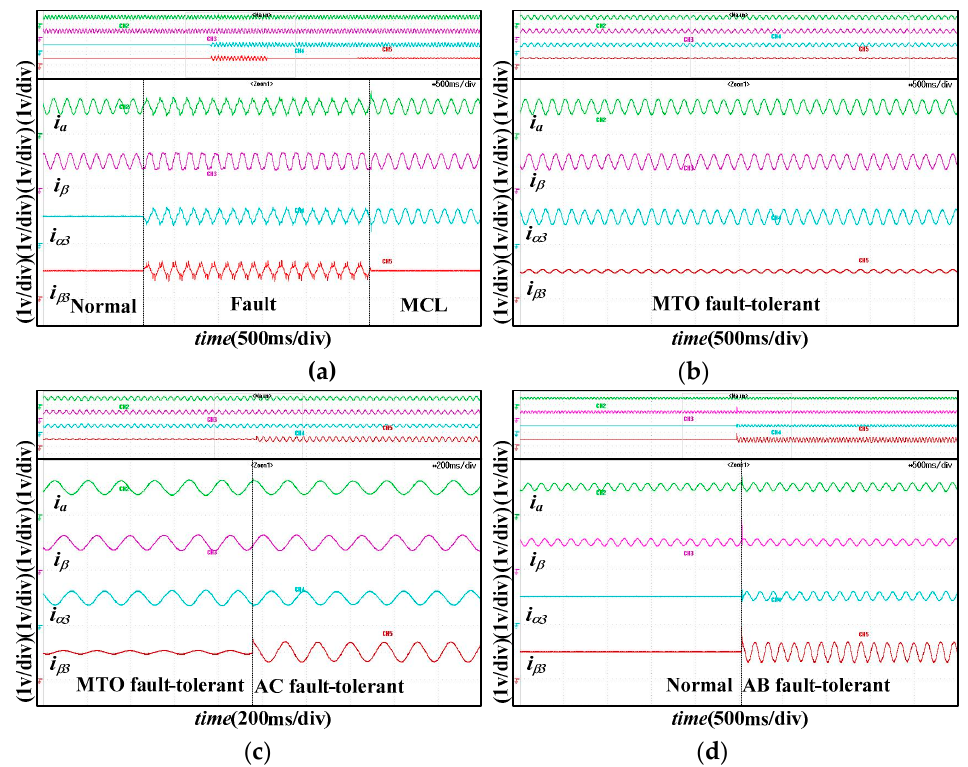
Figure 14. Changes of fault-tolerant control law: ( a ) normal to MCL; ( b ) MTO; ( c ) MTO to AC fault-tolerance; ( d ) normal to AB fault-tolerance.